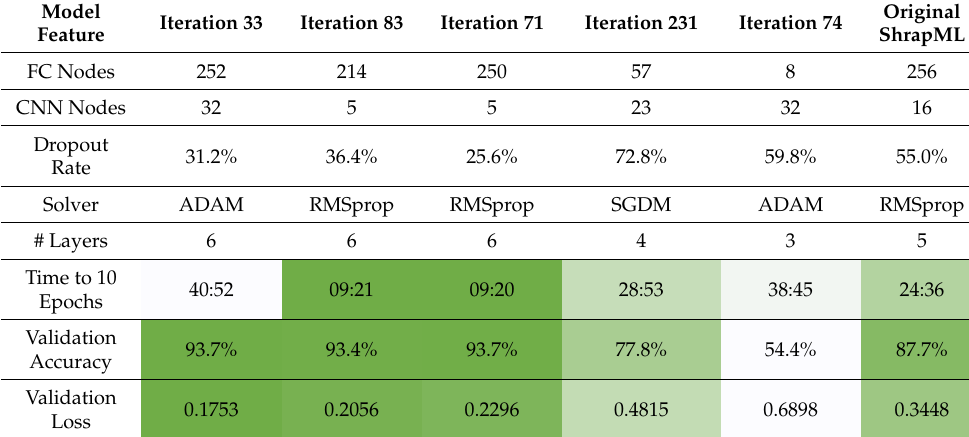
Table 3. Summary of results of the Bayesian optimization of ShrapML. Iterations 33, 83, and 71 were the three highest-performing iterations, based on validation loss. Iterations 231 and 74 were representative medium- and poor-performing iterations. The last column was results for 10 epochs of training from the original ShrapML model. The single-color heat map indicates best-performing models in green, with the worst being uncolored for each performance metric